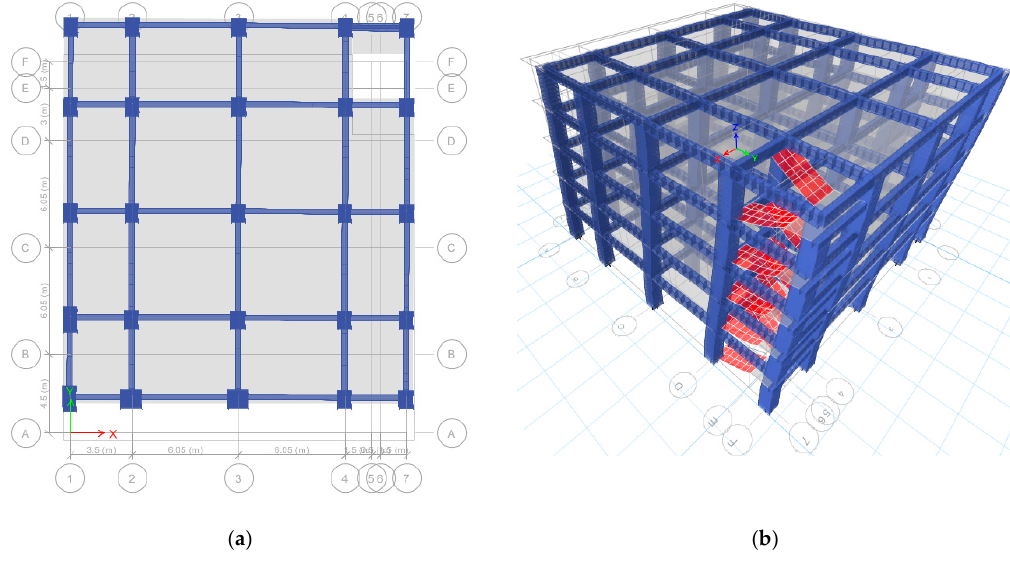
Figure 14. The 1st mode shape for T 2 = 0.376 s: ( a ) plane view, and ( b ) 3D view.